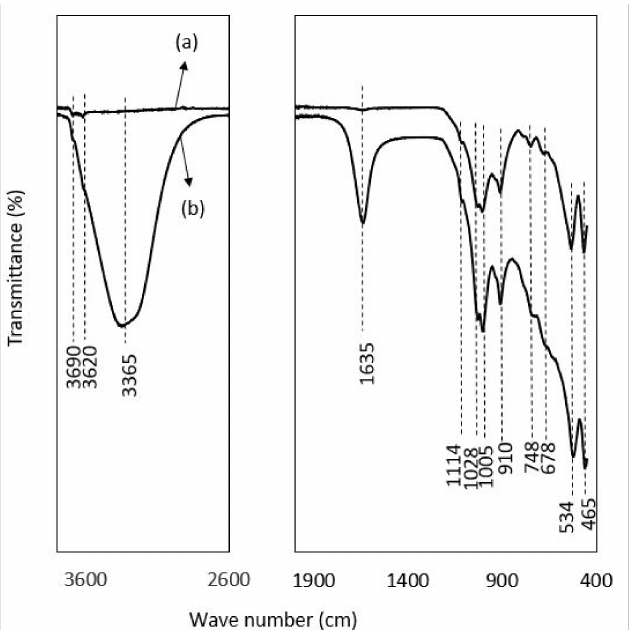
Figure 5. FTIR spectra showing the peak values of transmittance against wave numbers: ( a ) represents the spectra of raw kaolinite, and ( b ) is the spectra of laterite after